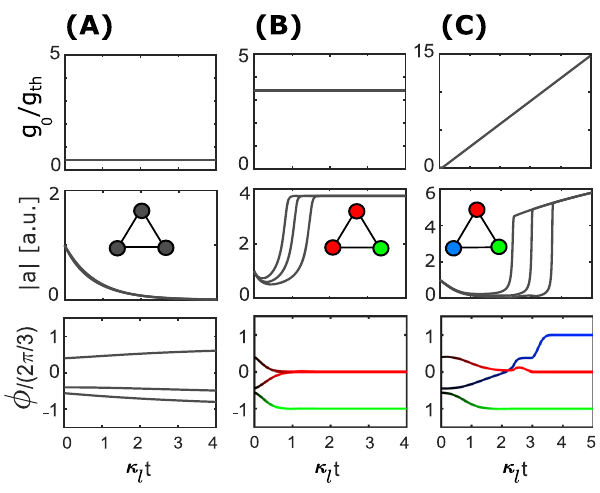
Figure 2: Dynamics of a three-spin system (inset) for different gain